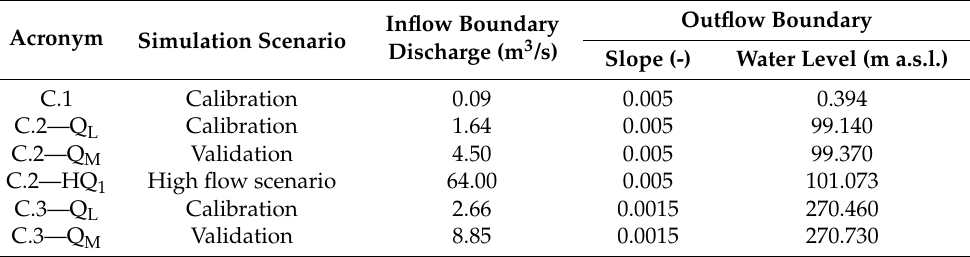
Table 3. Overview of boundary conditions for all simulation